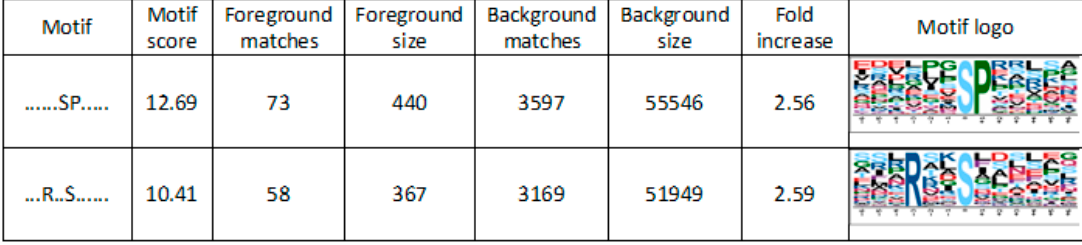
Figure 5. Motif-X analysis performed for overrepresented phosphorylation motifs of significantly regulated phosphosites in PSV-P- and PSV-P and satRNA-infected N. benthamiana leaves.